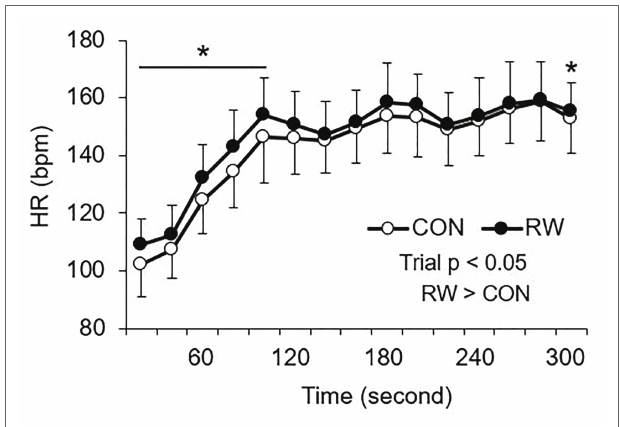
FIGURE 4 | Changes in mean HR in the initial 5 min of the second half. CON: 15-min seated rest trial, RW: 1-min re-warm up at high-intensity trial ( n = 12, mean ± SD). *Significant difference between the trials ( p <